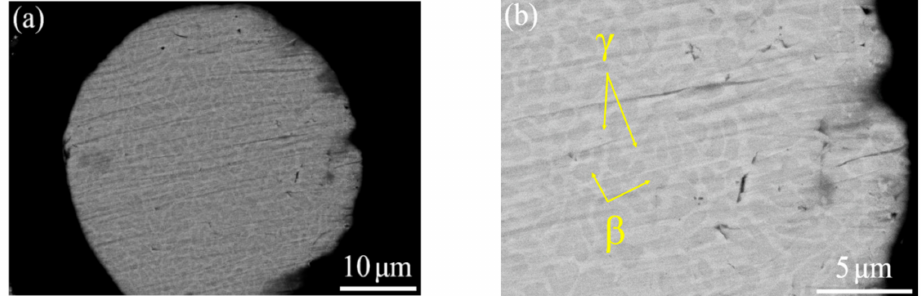
Figure 3. Cross-sectional microstructure of NiCrAlY powder at ( a ) low (2000 × ) and ( b ) high magnifications (5000 × ).